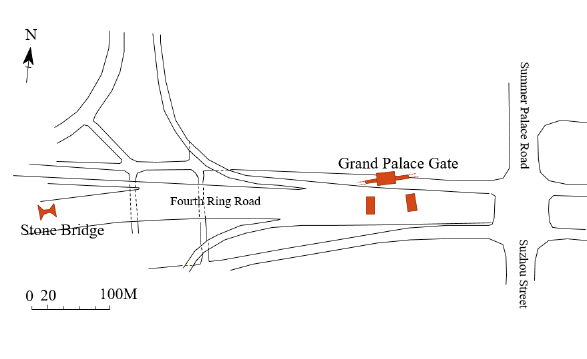
Figure 6. Map showing the location of the archaeological site of the Great Palace Gate in Changchun